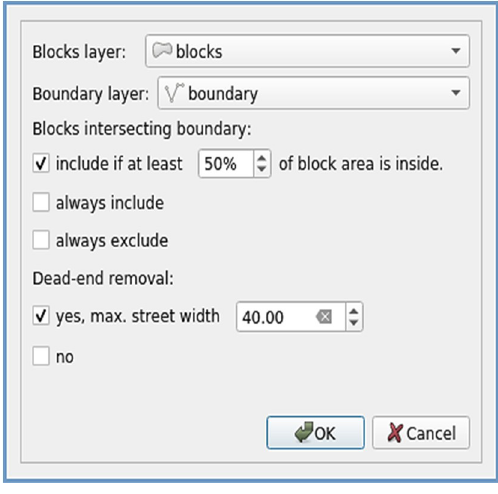
Figure 1. AwaP QGIS plugin interface.